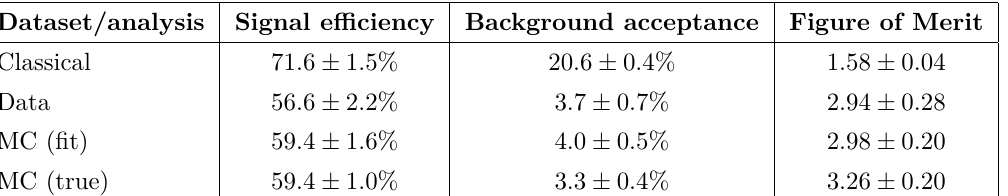
Figure 12 . 2D histogram of blob1 and blob2 energies of 1.6 MeV double escape peak events from detector data: (A) classical analysis; (B) RL deconvolution with the optimal choice of parameters. Each histogram contains events passing the fiducial cut and gross single-track cut with energies in the range 1 . 4 − 1 . 8 MeV, with both signal and background populations (with higher and lower blob2 energies, respectively). The horizontal white lines mark the choice of blob2 energy cut which maximizes the f.o.m .